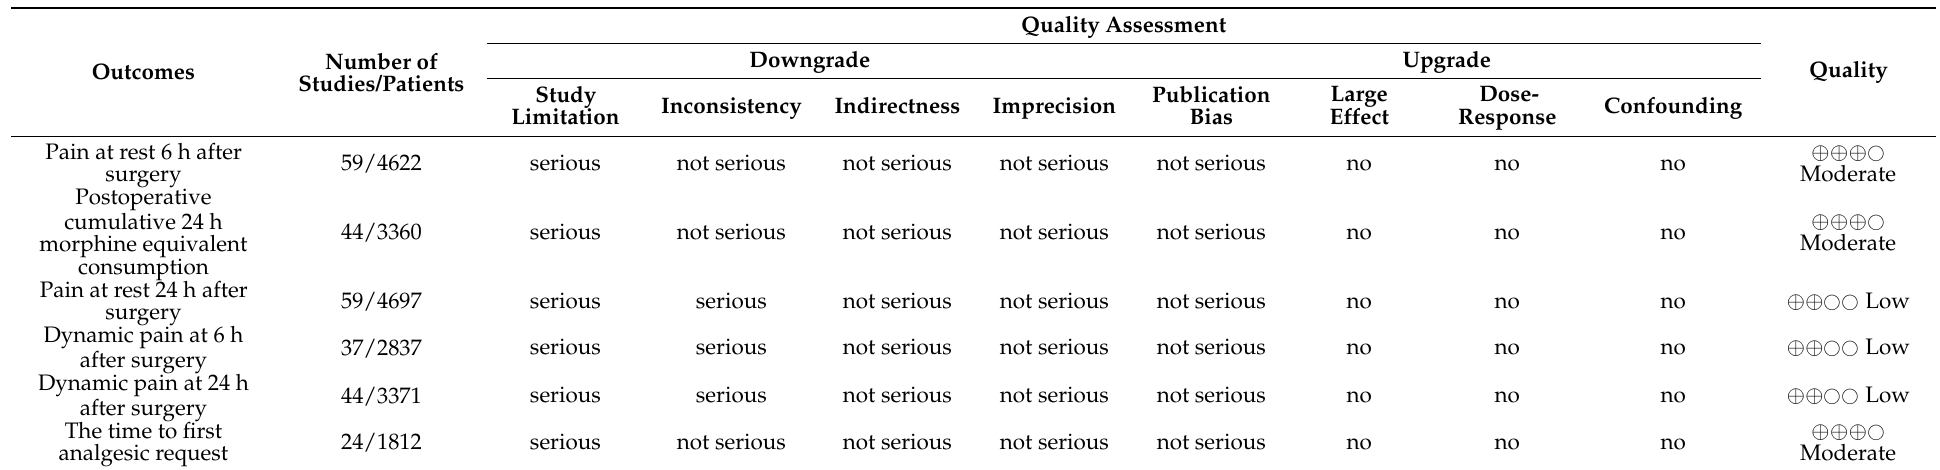
Table 2. The GRADE evidence quality for each